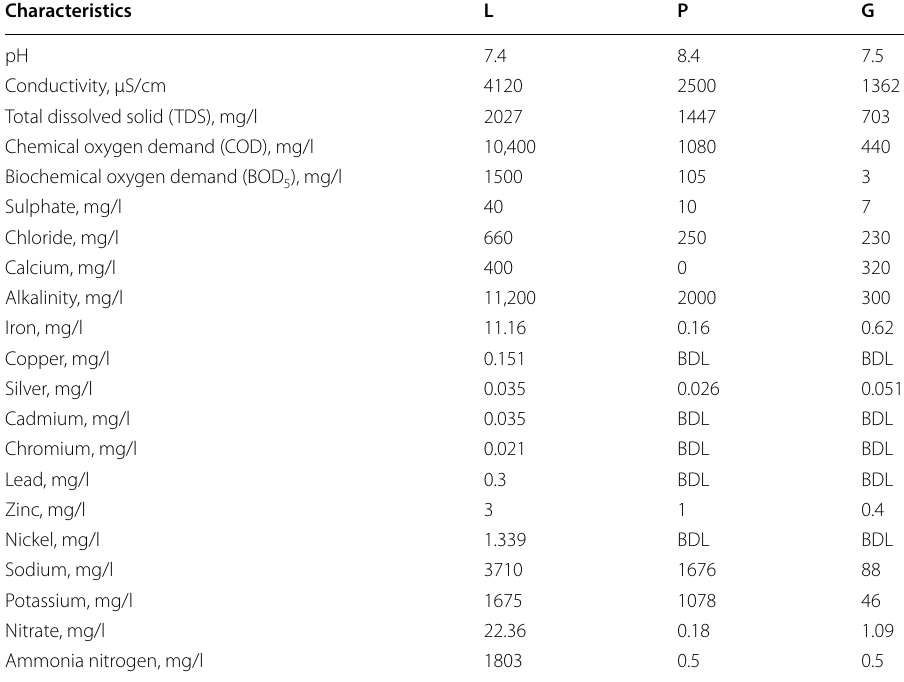
Parameter: Normal range for drinking